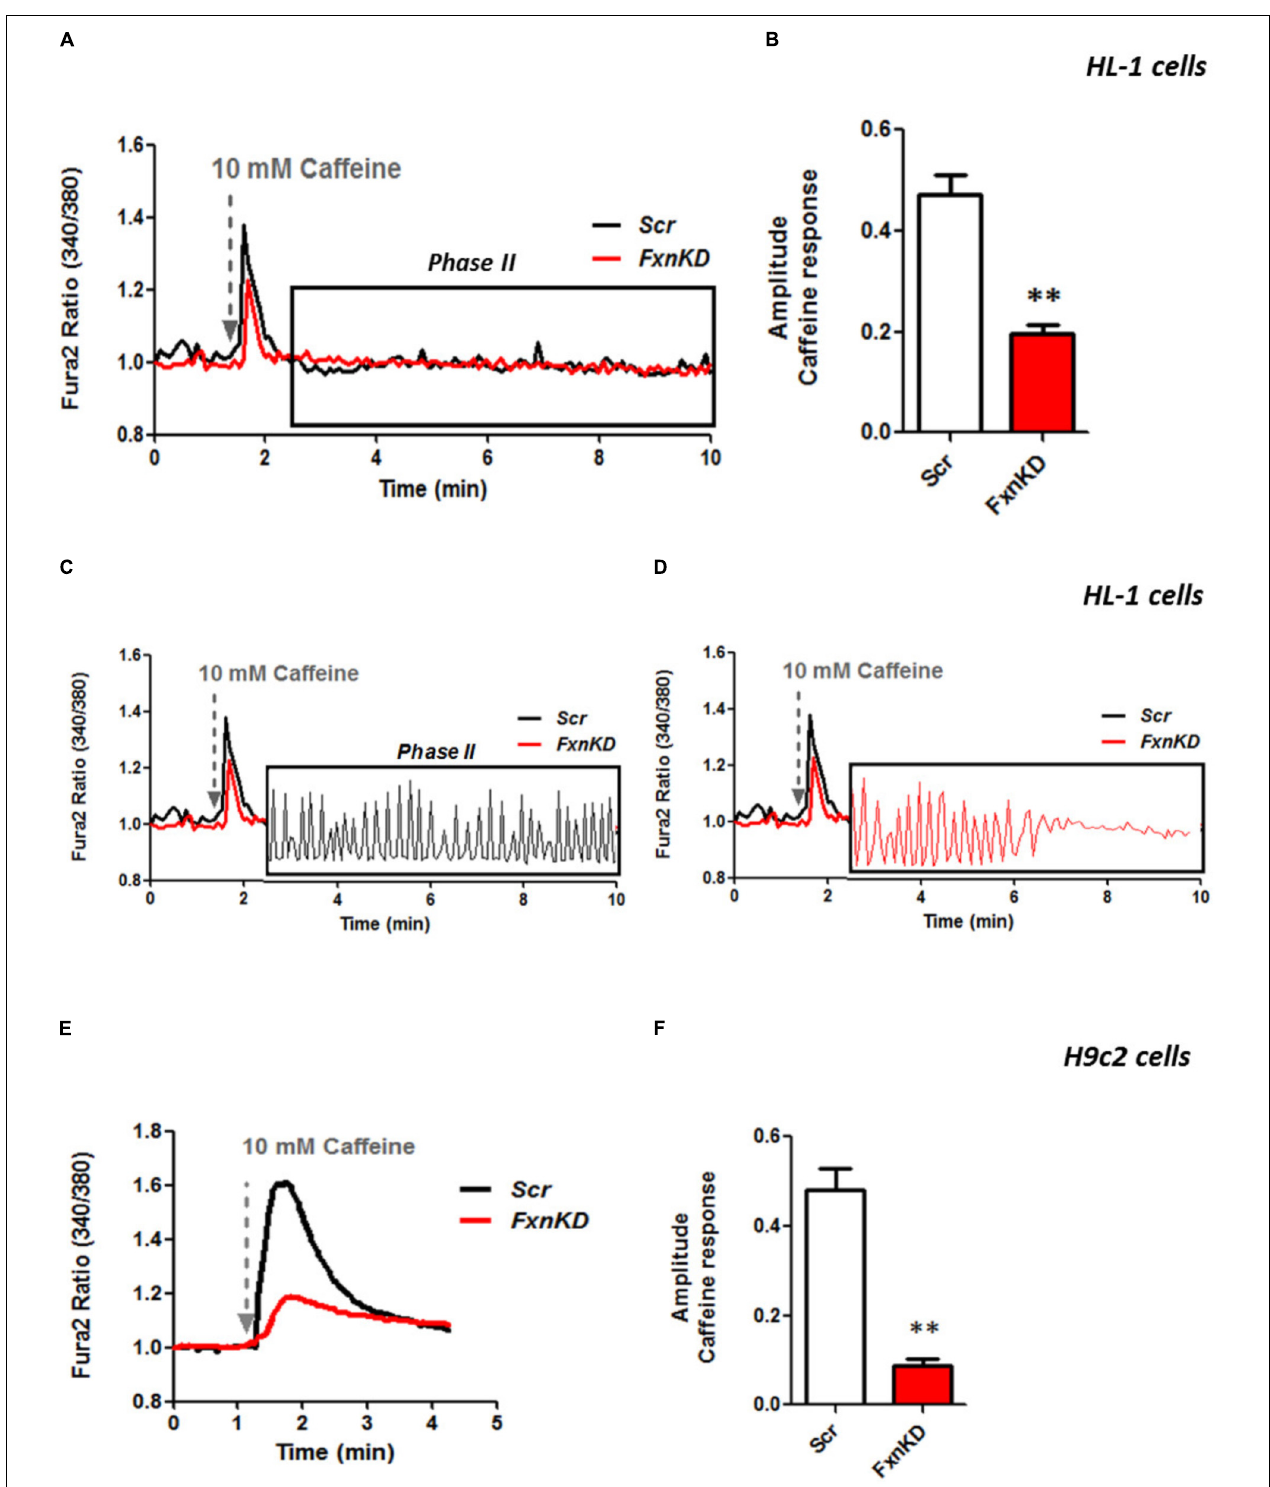
FIGURE 4 | FxnKD induces a smaller caffeine response and RyRs potentiation. (A,B) HL-1 cells FxnKD shows a smaller caffeine response compared to Scr cells. (A) Shows the kinetic of an average of cells and (B) reports the full sets of experiments combined together showing the decreased amplitude in FxnKD cells ( ∗∗ p < 0.005). (C,D) Highlight phase II of the Ca 2 + response in Scr cells and in FxnKD cells. Showing an early end of the Ca 2 + response probably ascribed to energy failure. (E,F) In H9c2 cells the diminished caffeine response in FxnKD was even more marked than HL-1 cells, however, the second phase of Ca 2 + response was flat and the receptors saturated ( ∗∗ p <